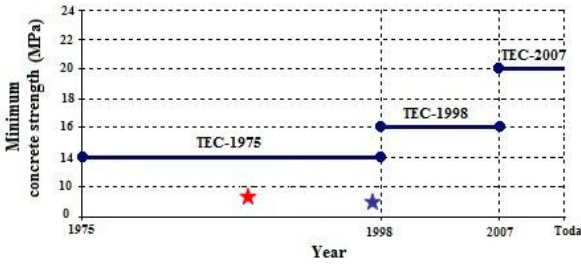
Fig. 24. Strength values of concrete used in the 1st (red star) and 2nd (blue star) building and the change of lower limit of concrete compressive strength according to